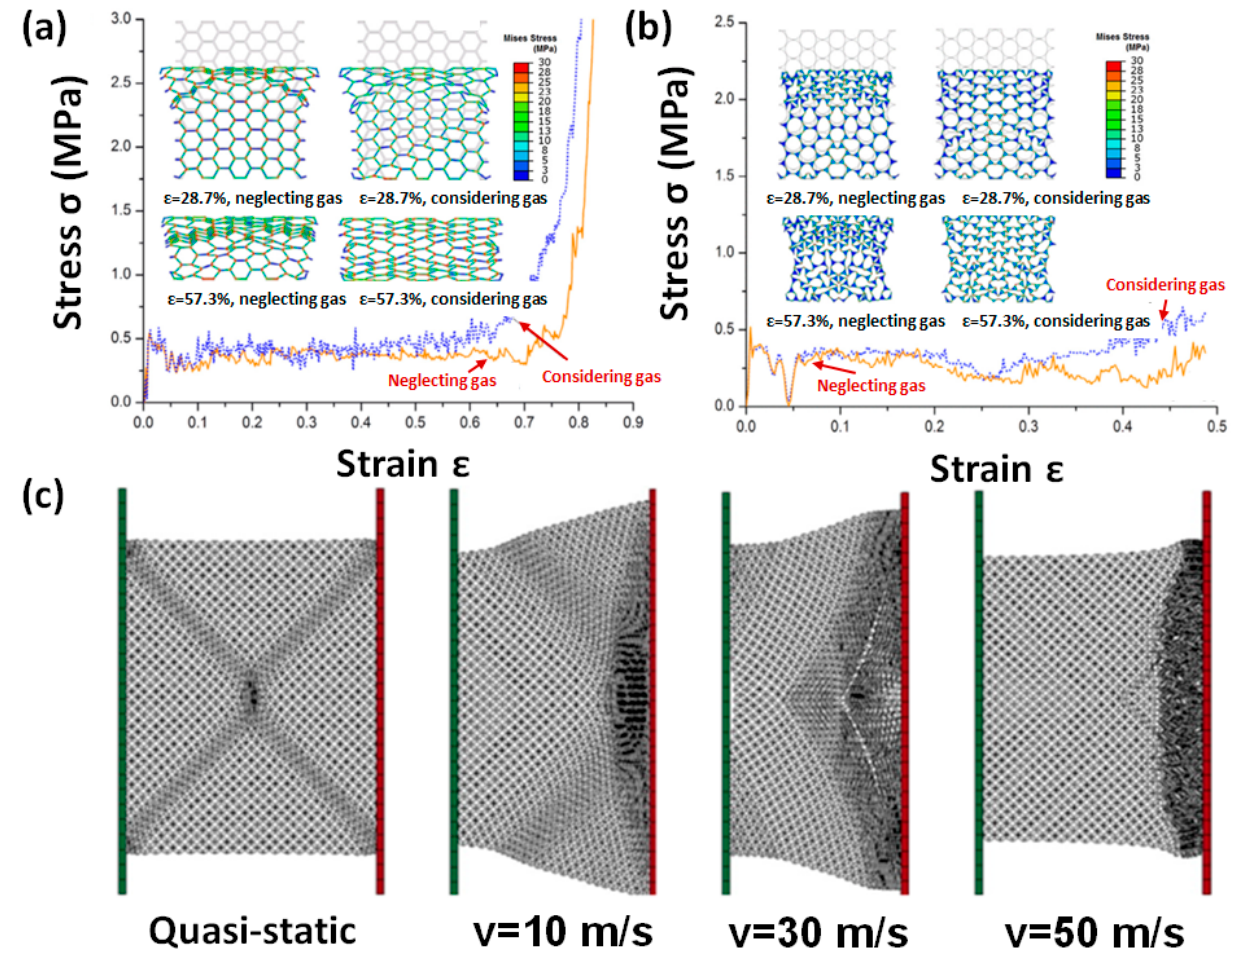
Figure 8. ( a ) Stress-strain curves of hexagonal-cell model at 100 s − 1 [120], ( b ) stress-strain curves of circular-cell model at 100 s − 1 [120], and ( c ) deformation mode of c-a model at different impact speeds [119].